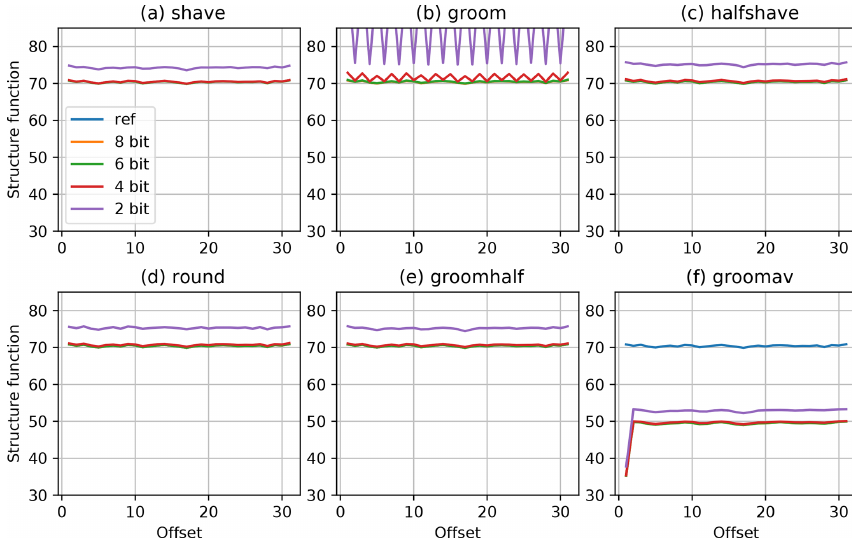
Figure 4. The structure function (Eq. 3) of the signal shown in Fig. 2b, processed with different precision